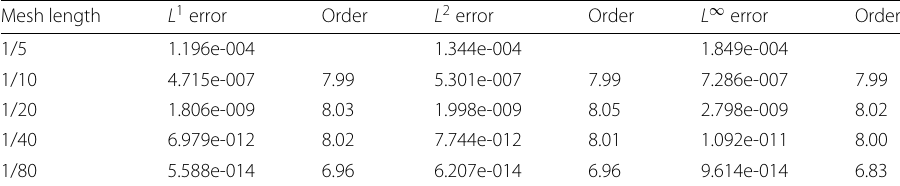
Table 2 1-D accuracy test: errors and convergence orders of 8th-order compact linear scheme with (cid:10) t = 0.3 (cid:10) x 2